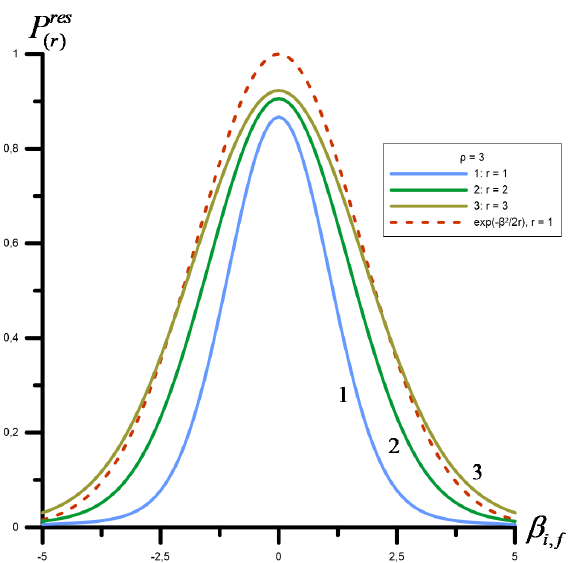
Figure 4. The resonance profile function P res (68) dependency on the parameter β i , f , (11) with ρ = 3. ( r ) The curves 1, 2, 3 outline the resonances. The dashed line is the Gauss